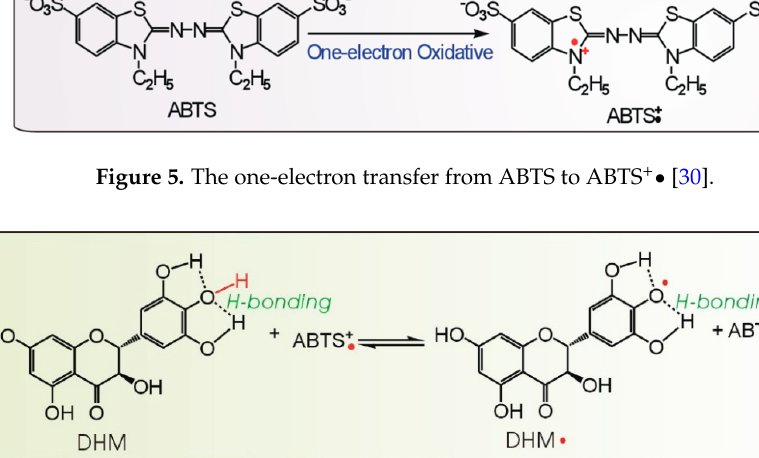
Figure 6. The proposed reaction of DHM with the ABTS + • radical cation (initial stage).